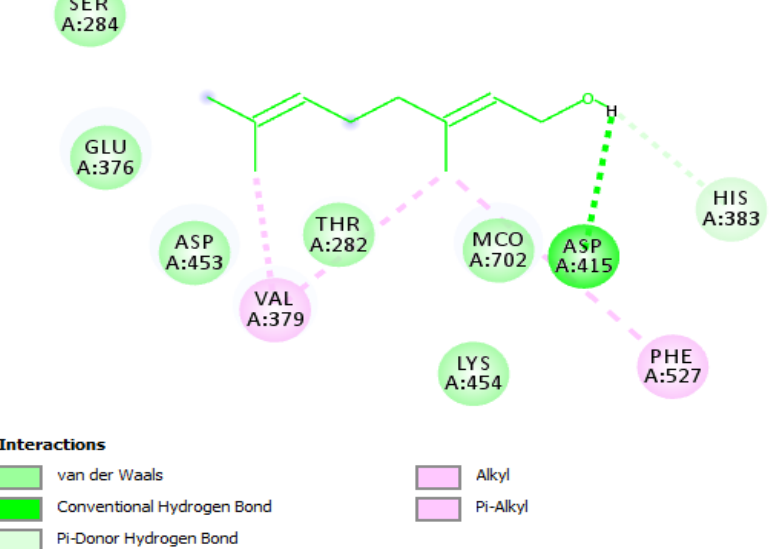
Figure 5. 2D diagram shows the binding mode of geraniol in the active cavity of the ACE. Only those amino acid residues embroiled in ACE stabilization are viewed. Hydrogen bonding and several fundamental interactions with corresponding amino acid residues are presented.